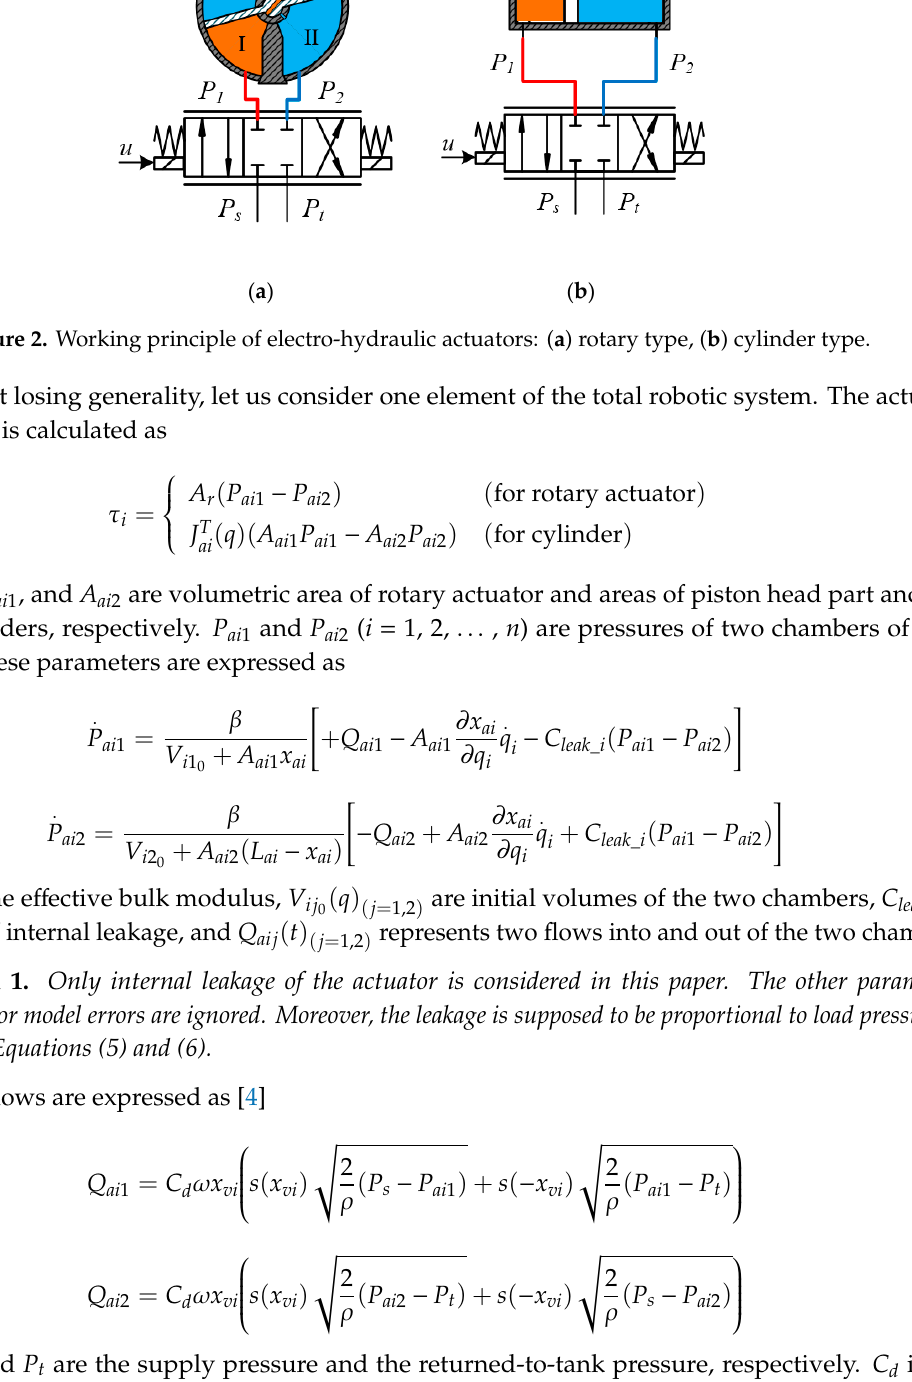
Figure 1. Architecture of the n-DOF serial hydraulic manipulator.